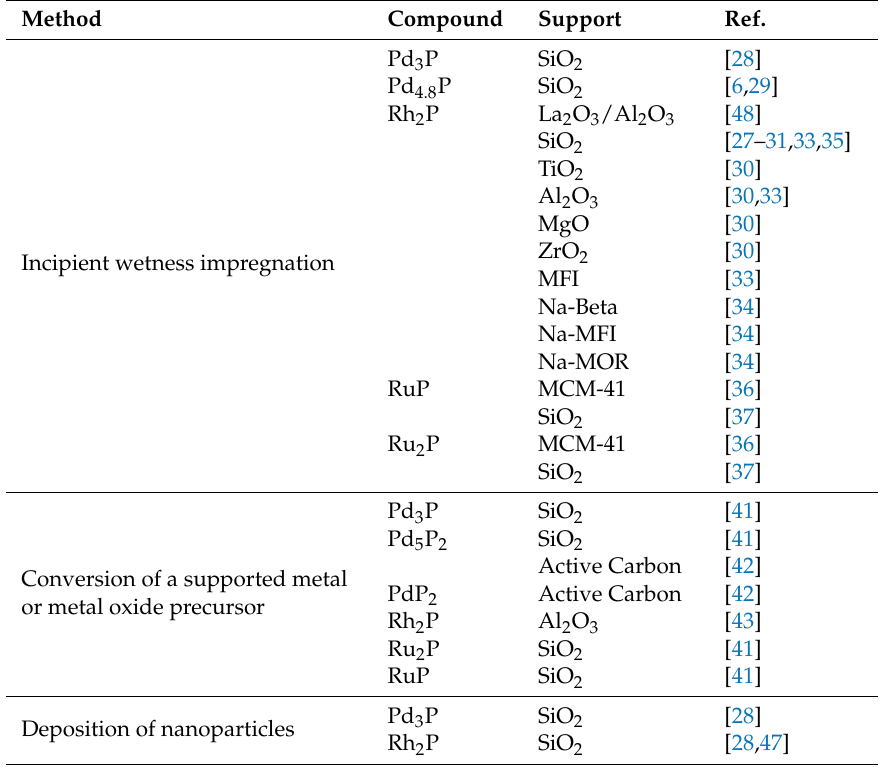
Table 2. Overview of the methods applied for the preparation of supported